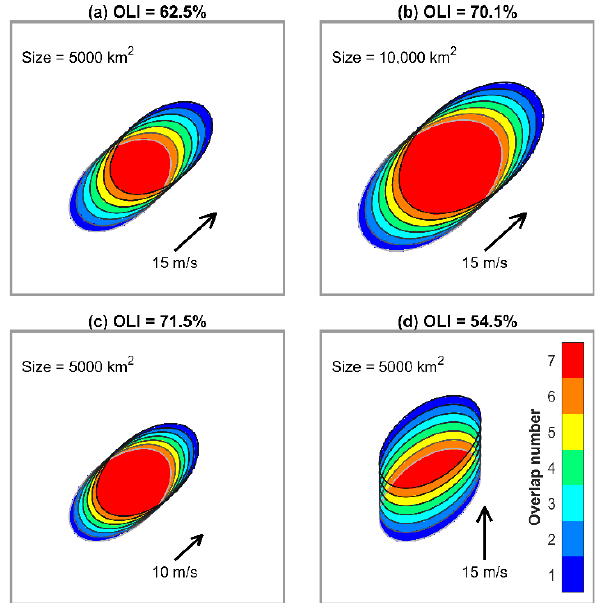
Figure 10. Schematic diagrams showing how the proposed overlap index (OLI) varies with the size, moving speed of MCS, and the angle between the MCS orientation and moving direction. In ( a ), the MCS sample has a size of 5000 km 2 , a linear shape with an eccentricity of 0.2, a northeast–southwest orientation, and moves northeastward at a speed of 15 m s − 1 . Panels ( b – d ) are similar to ( a ), except the size is 10,000 km 2 in ( b ), the moving speed is 10 m s − 1 in ( c ), and the moving direction is northward in ( d ). The calculation of OLI is based on the Himawari-8 infrared images, with a pixel resolution of 2 km and a scan interval of 10 min, by extrapolating the targeted MCS sample for one hour (i.e., a total of seven timestamps as denoted by the rings in each panel). For an MCS sample, a larger proportion of pixels with higher overlap numbers along the MCS pathway tend to produce a larger